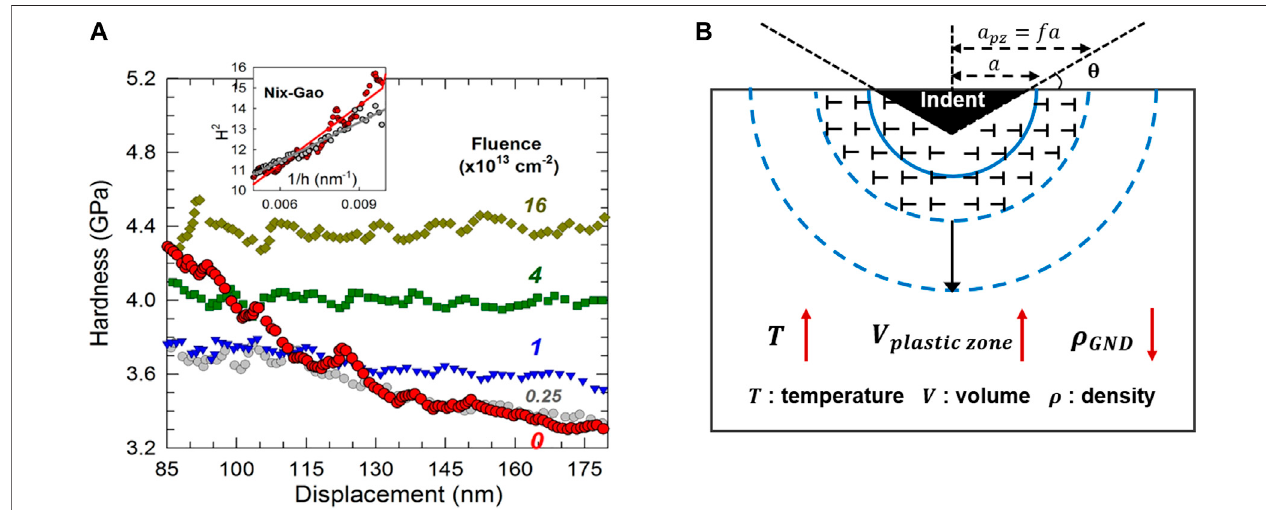
FIGURE 3 | (A) Nanoindentation hardness as a function of displacement at a variety of irradiation in fl uence. Insert shows the Nix-Gao model fi tted line [Reprinted with permission from Jin et al. (2018). Copyright 2018 by Elsevier]. (B) Schematic drawing for the plastic zone evolution (the GNDs stored volume) with the change of